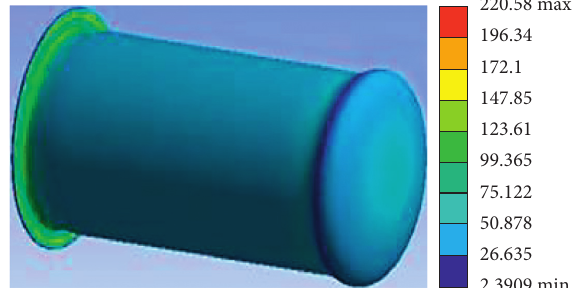
Figure 24: Equivalent stress cloud diagram of the coupled flame tube.